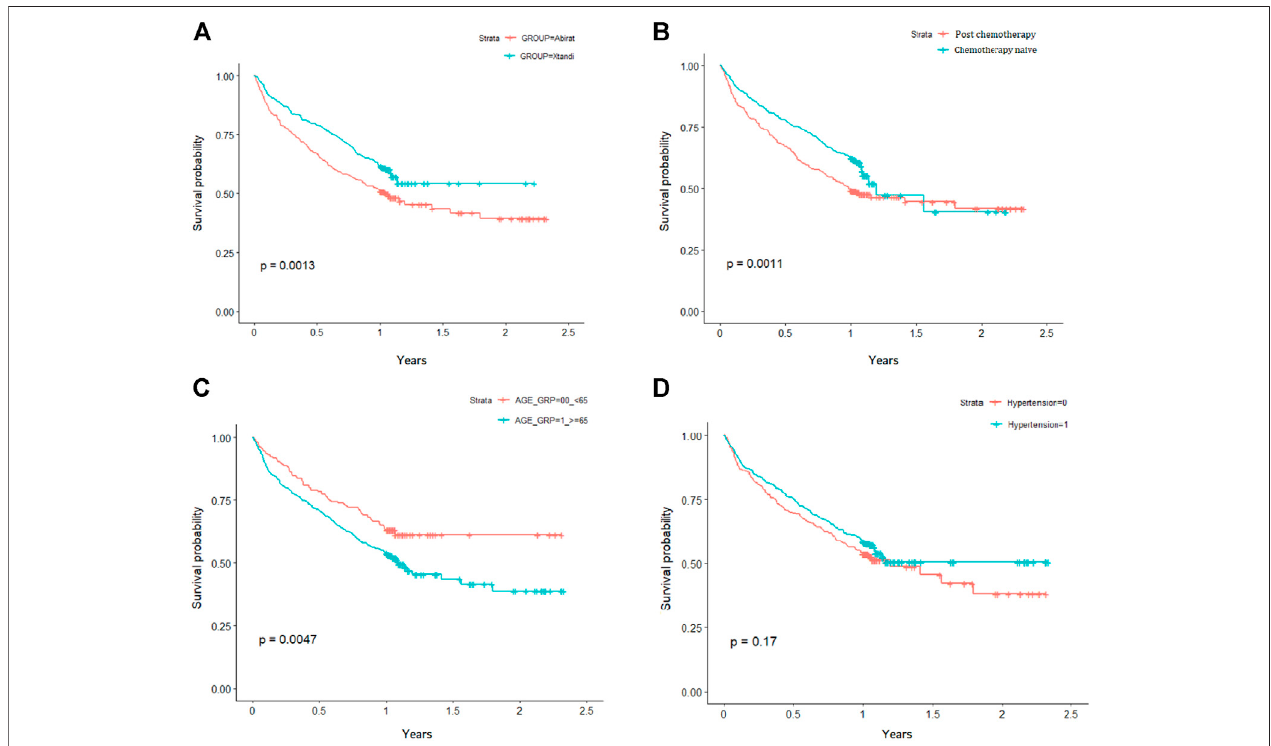
FIGURE 2 | Kaplan-Meier analysis for overall survival, strati fi ed by (A) abiraterone/enzalutamide (B) chemotherapy (C) age; and (D) hypertension status.